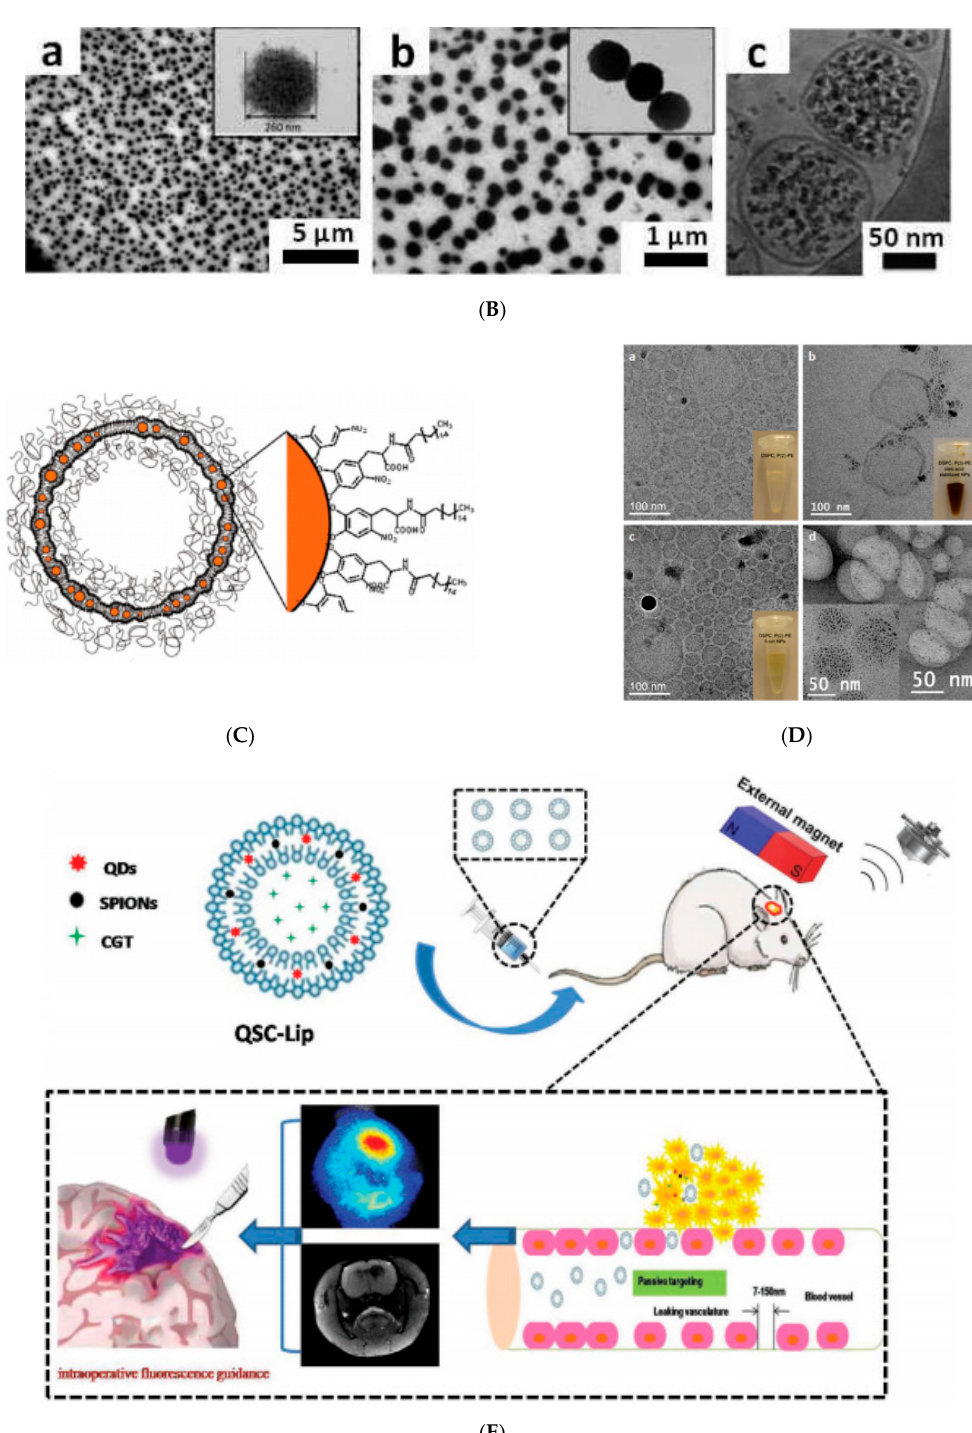
Figure 5. ( A ) Schematic showing the preparation (upper) and assembly (lower) of LipoMag. Oleic acid-coated magnetic nanocrystal cores and the lipid shells form through hydrophobic interactions (reprinted by permission from Copyright Clearance Center: Springer Nature, Nature Nanotechnology, [158], Copyright 2009). ( B ) ( a , b ) TEM and ( c ) cryo-TEM micrographs of UMLs prepared by an REV process. At low magnification, a large number of dense vesicles are observed with diameters 200 nm in average. MNPs are trapped inside unilamellar vesicles ( c ) and dipole − dipole interaction can occur as exemplified by magnification ( b ). (Reprinted with permission from [64]. Copyright 2012 American Chemical Society). ( C ) Schematic of liposomes containing iron